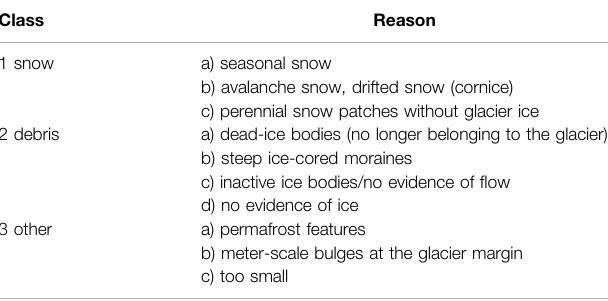
TABLE 1 | Classes of the topographical glacier outline data set (TLMglac) that were removed for the SGI2016, including the reason.